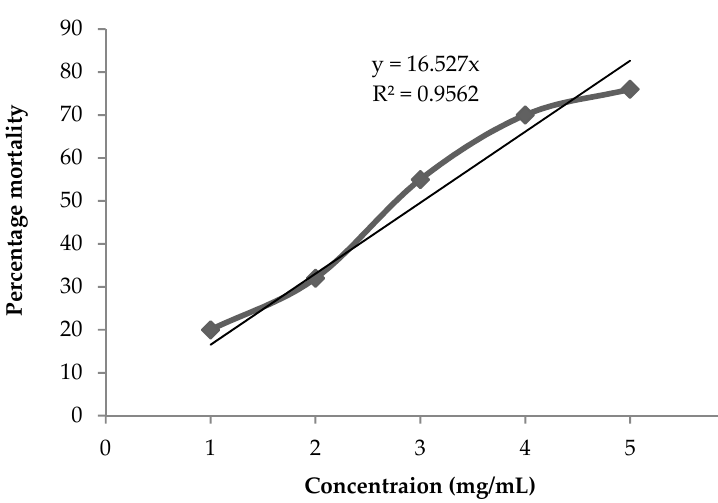
Figure 5. Cytotoxic effect of DSAgNPs against Artemia salina.